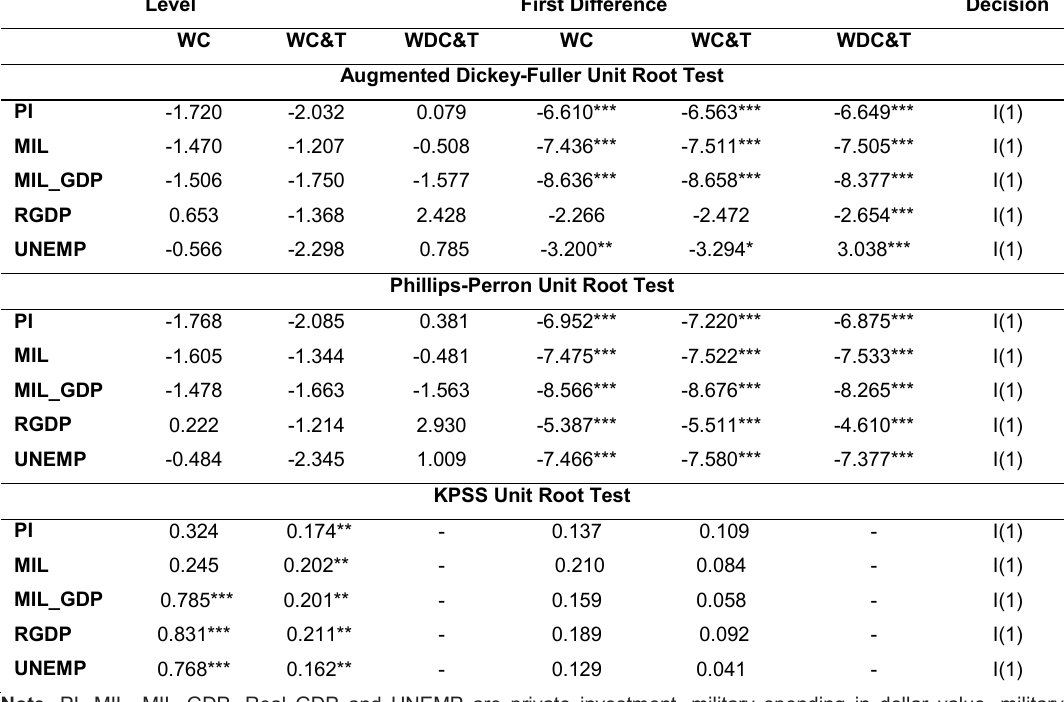
Table 4. Unit Root Test